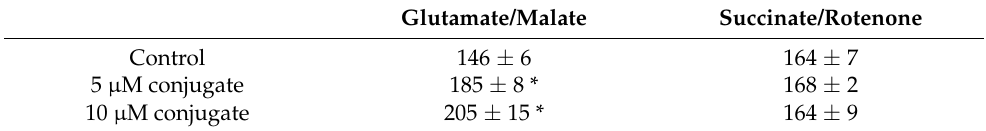
Table 4. Effect of F16-betulin on the rate of H 2 O 2 generation by mitochondria (H 2 O 2 /min/mg protein).